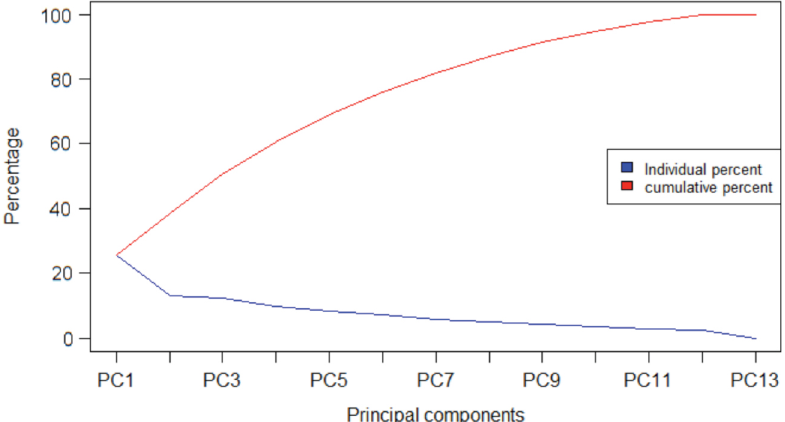
Figure 3: Screen plot of the PCA, showing the percentage of explained data variability for each principal component ob- tained. The blue line corresponds to the individual percentage and the red one to the cumulative percentage.